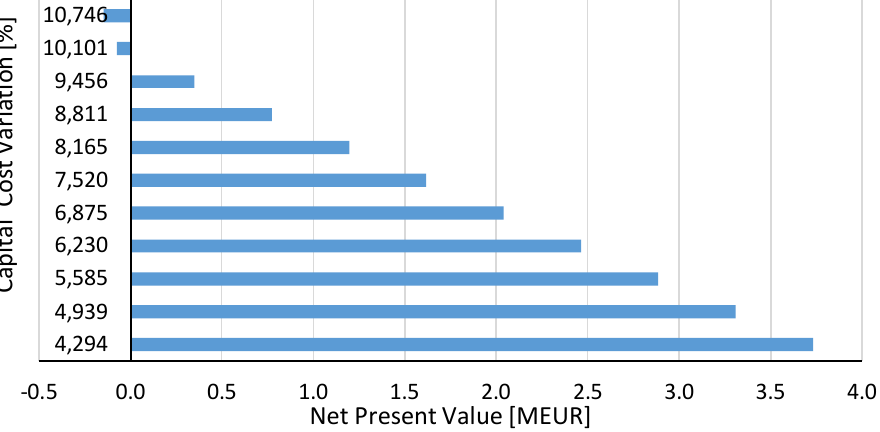
Figure 8. CAPEX of SOFC+MED influence on Net Present Value.